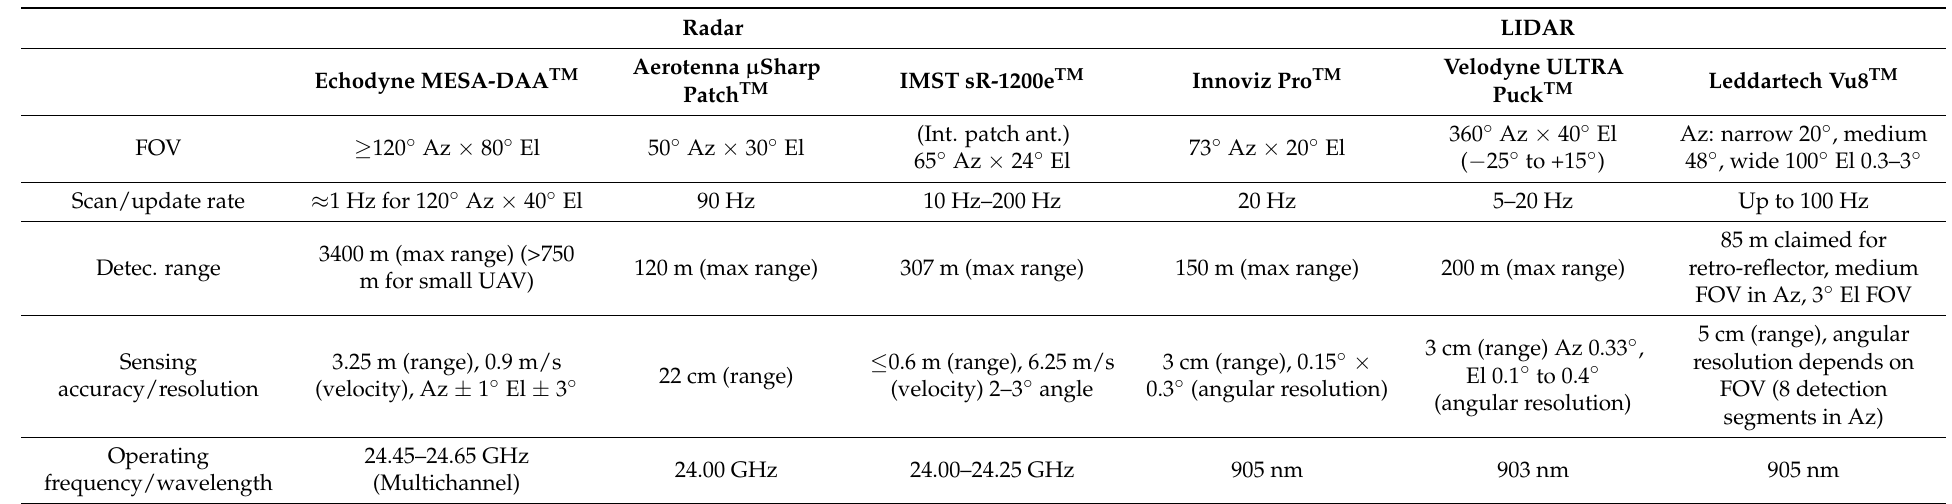
Table 2. Main specifications of radar and LIDAR systems described in